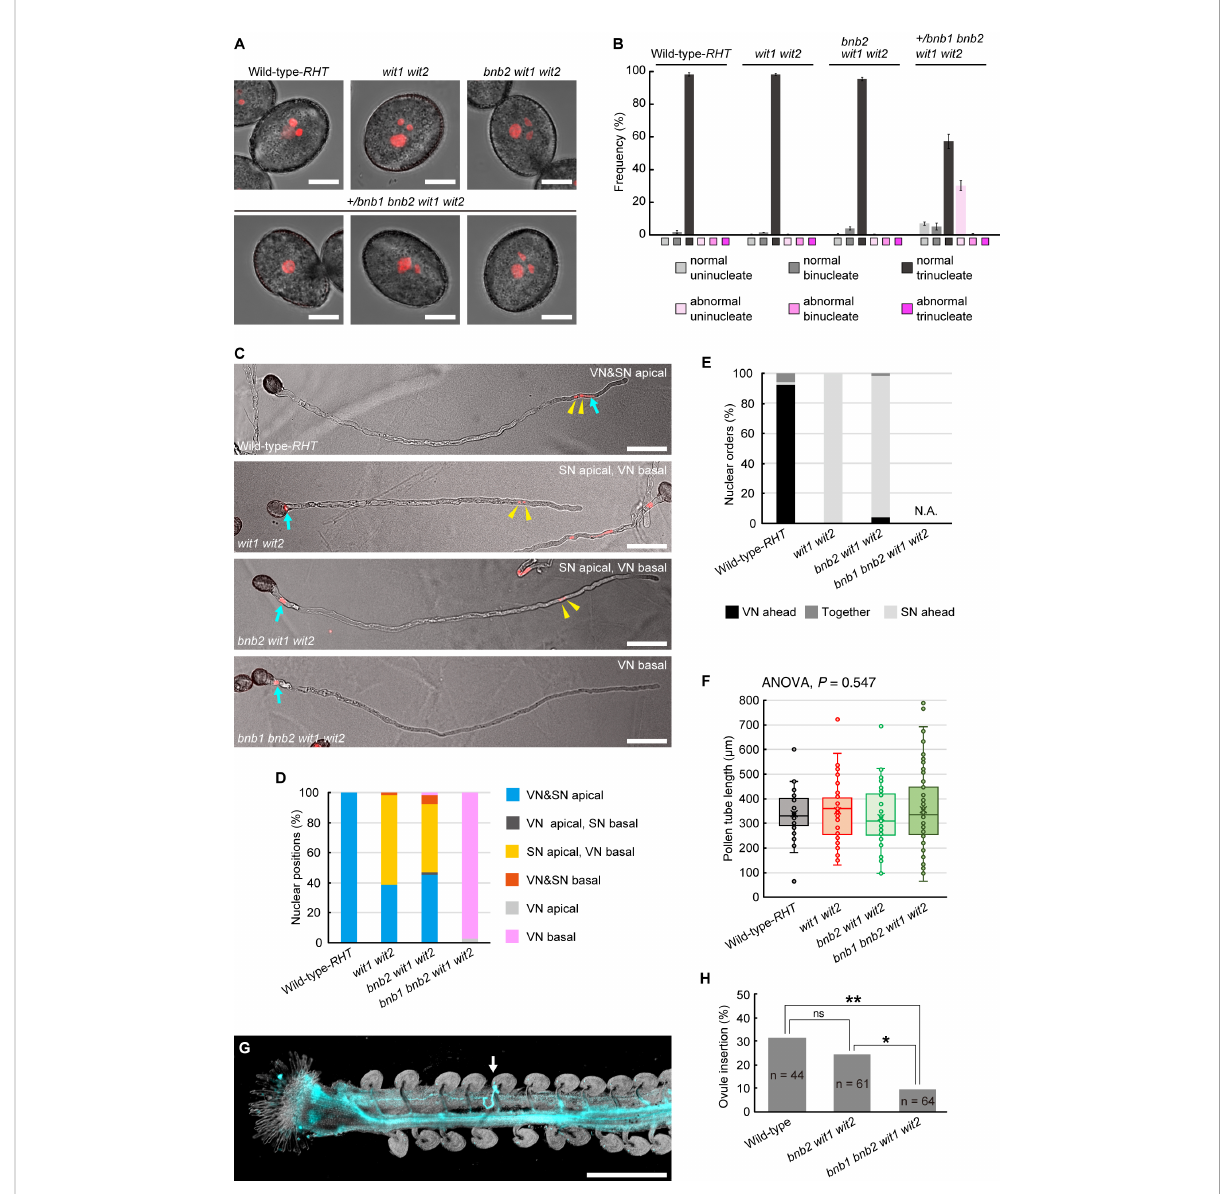
FIGURE 1 Pollen tube behavior in +/ bnb1 bnb2 wit1 wit2 mutant plants. (A) Representative images of mature transgenic pollen carrying the pRPS5A:H2B- tdTomato ( RHT ) plasmid of the wildtype (WT) Col-0 plant (WT- RHT ), wit1 wit2 double homozygous mutant, bnb2 wit1 wit2 triple homozygous mutant or +/ bnb1 heterozygous, and bnb2 wit1 wit2 triple homozygous mutant (+/ bnb1 bnb2 wit1 wit2 ). The three images represent an abnormal uninucleate (left), a normal binucleate (center), and a normal trinucleate (right) pollen from the +/ bnb1 bnb2 wit1 wit2 mutant. Scale bars: 10 m m. (B) Pollen nucleation frequencies in the four genotypes observed in (A) , considering both the number of nuclei and shape of pollen grains. Normal indicates pollen of normal contour. At least three independent observations were conducted, with a total of 572 to 1,160 pollen grains. (C) Representative images of WT- RHT , wit1 wit2 , bnb2 wit1 wit2 , and bnb1 bnb2 wit1 wit2 pollen tubes 3 h post-germination in vitro . Blue arrows and yellow arrowheads indicate vegetative nuclei (VN) and sperm nuclei (SN) pairs, respectively. Scale bars: 50 m m. (D, E) Nuclear positions (D) and nuclear orders (E) analyzed in the WT- RHT , wit1 wit2 , bnb2 wit1 wit2 , and bnb1 bnb2 wit1 wit2 mutant pollen tubes. For each plant genotype, 51 to 65 pollen tubes were observed. (F) Box-and-whisker plots of pollen tube length analyzed in the same samples as in (D) and (E) . Note that we observed only bnb1 bnb2 wit1 wit2 quadruple pollen tubes with one nucleus out of 65 pollen grains from +/ bnb1 bnb2 wit1 wit2 mutants in (C) to (F) . (G) Representative image of an ovule penetrated by a bnb1 bnb2 wit1 wit2 quadruple mutant pollen tube (white arrow). In the in-vivo single-pollen-tube guidance assay, a pistil was harvested one day after pollination and observed after aniline blue staining. Scale bar: 500 m m. (H) Ovule-insertion analyzed in the in-vivo single pollen tube guidance assay of the WT, bnb2 wit1 wit2 , and bnb1 bnb2 wit1 wit2 mutant pollen. Statistics: Chi-square test with a p -value adjustment by the Hochberg algorithm. ns, not signi fi cant. * P = 0.0459. ** P =